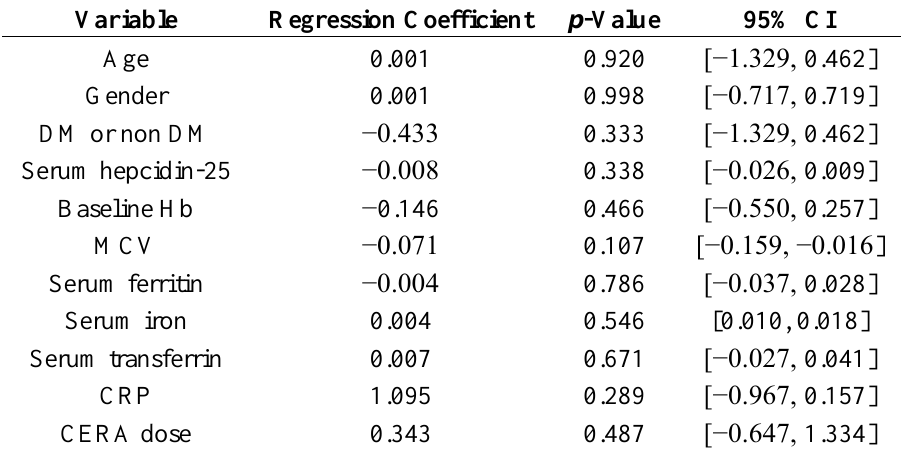
Figure 2. Correlation between serum levels of CRP with baseline levels of serum hepcidin-25, ferritin, and MCV before OIT in responders and non-responders. There is a significant and positive correlation between CRP and serum hepcidin-25 (Figure 2a, r = 0.51, p < 0.01) as well as serum ferritin (Figure 2b, r = 0.61, p < 0.01). However, no correlation was found between CRP and MCV (Figure 2c, r = 0.27, p = 0.97). Table 4. Contribution of variables to OIT response with ΔHb increment evaluated by multiple linear regression